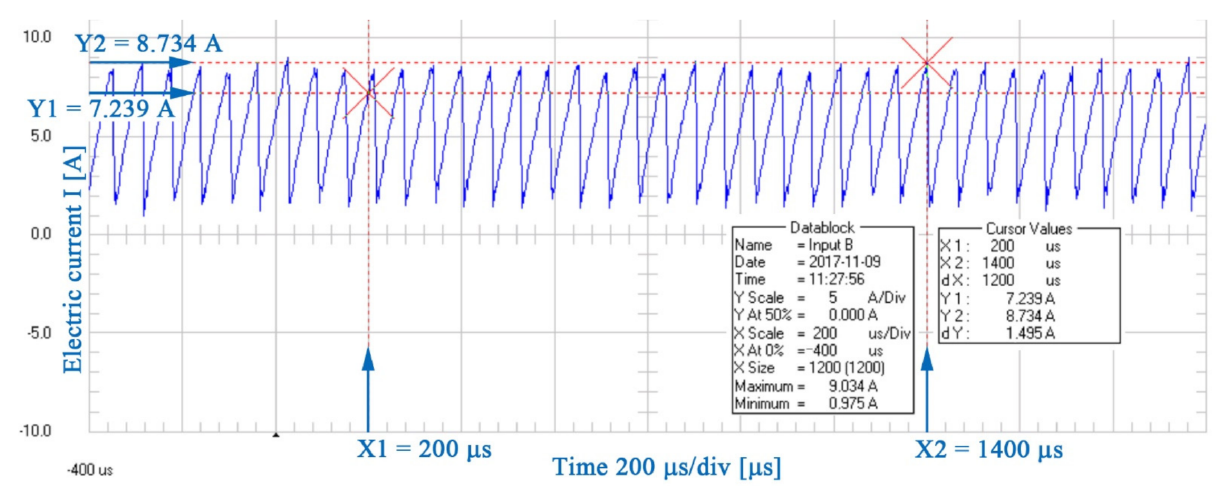
Figure 15. Battery charging current waveform—average battery charging current